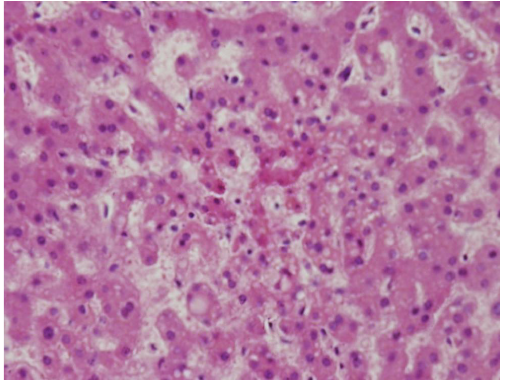
Figure 3: Microscopic appearance of liver shows patchy